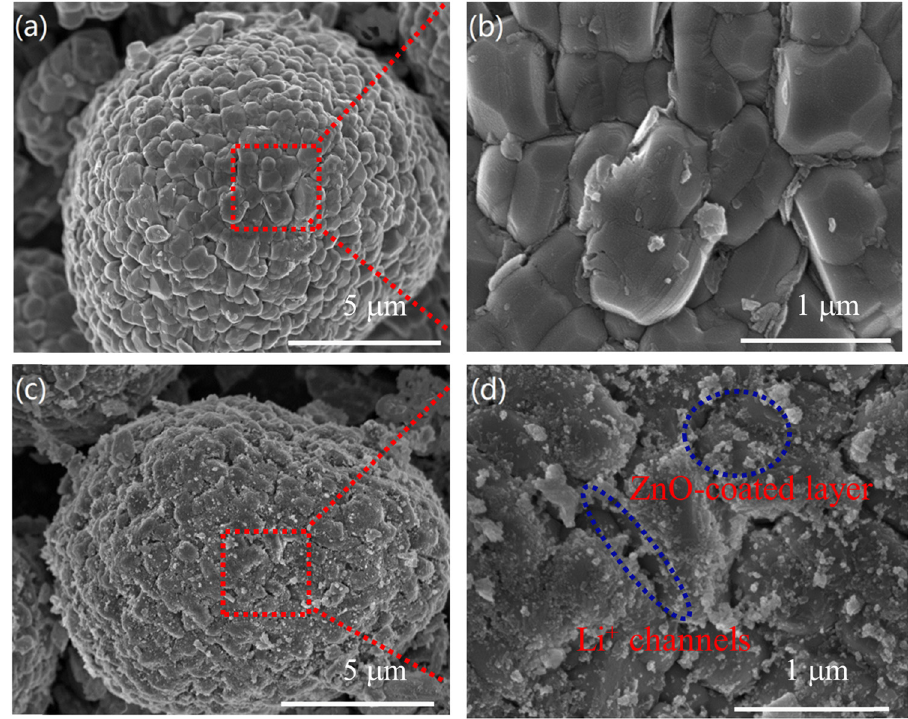
Figure 7: SEM images of the ( a and b ) pristine and ( c and d ) 1 wt% ZnO - coated LiNi 0.8 Co 0.15 Al 0.05 O 2 samples.